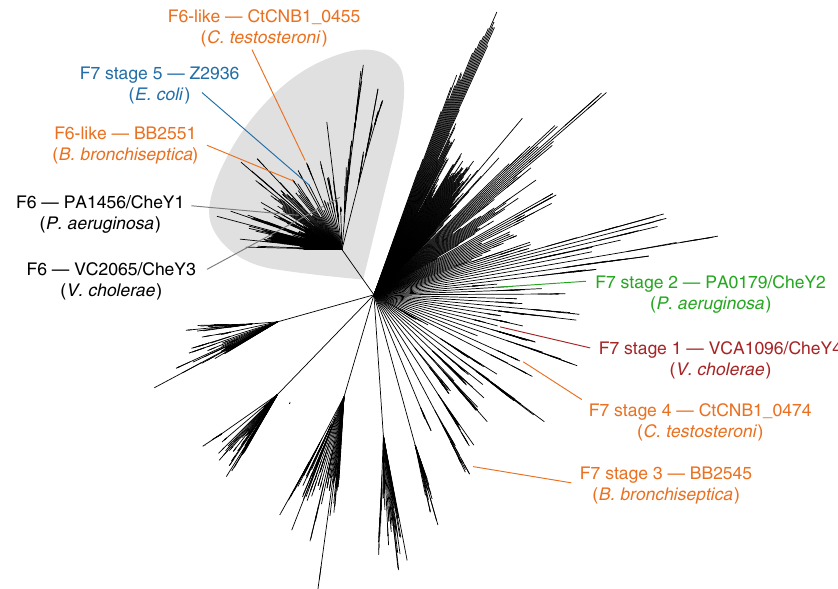
Fig. 4 Phylogenetic reconstruction of CheY in selected proteobacterial genomes. Sequences of CheY proteins from F6, F6-like, and F7 stage 5 systems cluster in a monophyletic group (grey shade). CheY sequences from the F7 systems of other stages (1 – 4) appear in other clades, indicating that F6-like and F7 stage 5 CheYs are more closely related to CheYs from F6, than F7 systems. Nodes are collapsed on 50% bootstrap support. For each stage, a representative sequence is highlighted, named with the type of its CheY, the locus number/gene name (when annotated) and the name of the organism to which it belongs. The representative genomes for each stage are: Stage 1: Vibrio cholerae , Stage 2: Pseudomonas aeruginosa , Stage 3: Bordetella bronchiseptica , Stage 4: Comamonas testosteroni , and Stage5: Escherichia coli . These sequence names follow the color code of stages in Fig. 3.